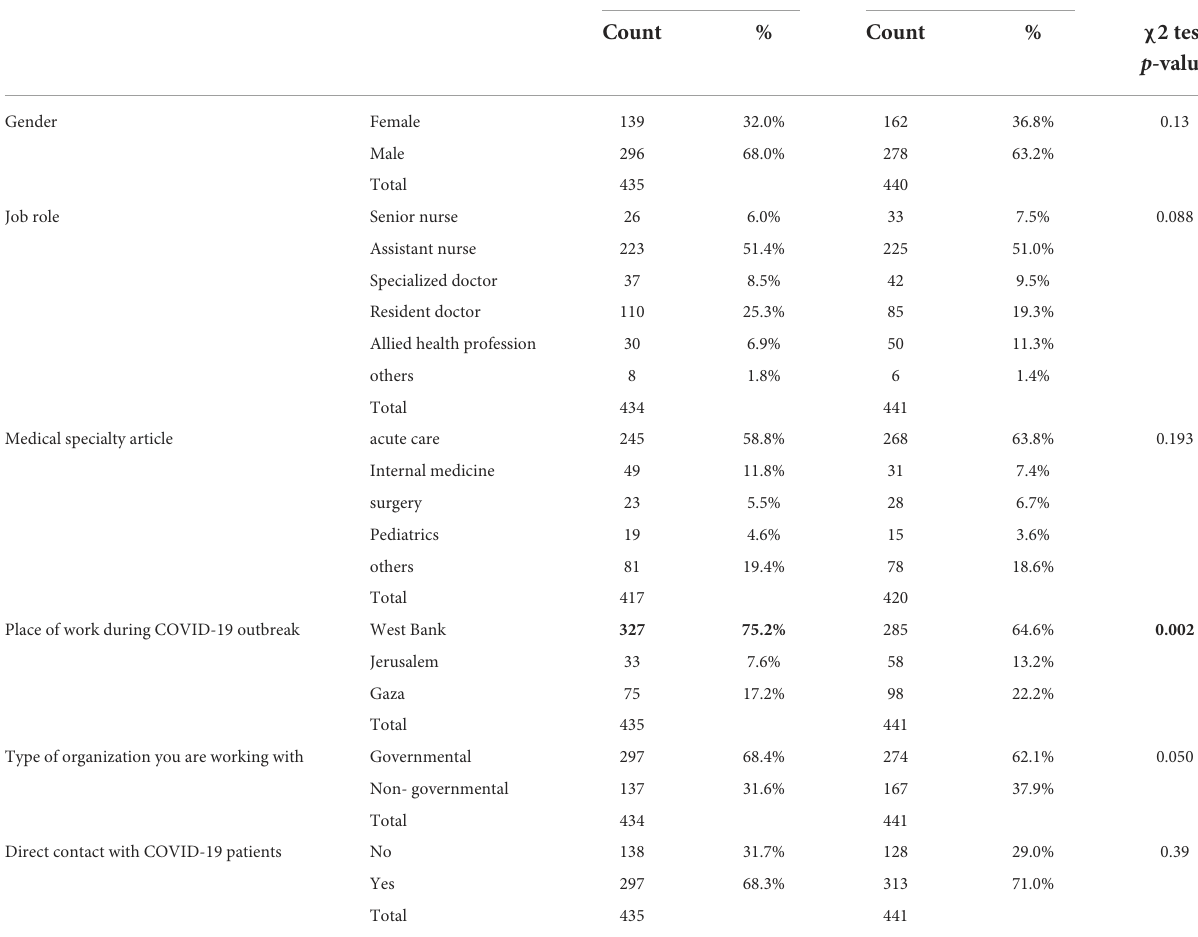
TABLE 2 Trust with cutoff point 50% in comparison with study